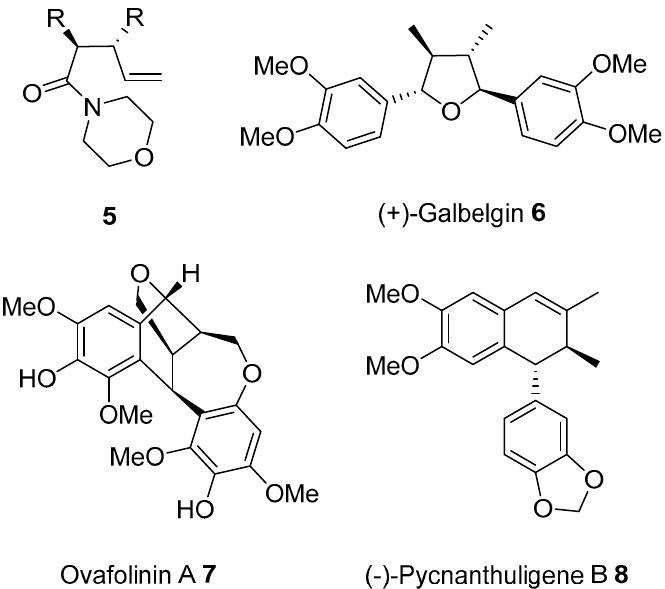
Figure 2. Use of amide 5 , the product of an acyl-Claisen rearrangement to access a number of lignan scaffolds and natural products 6 – 8 .